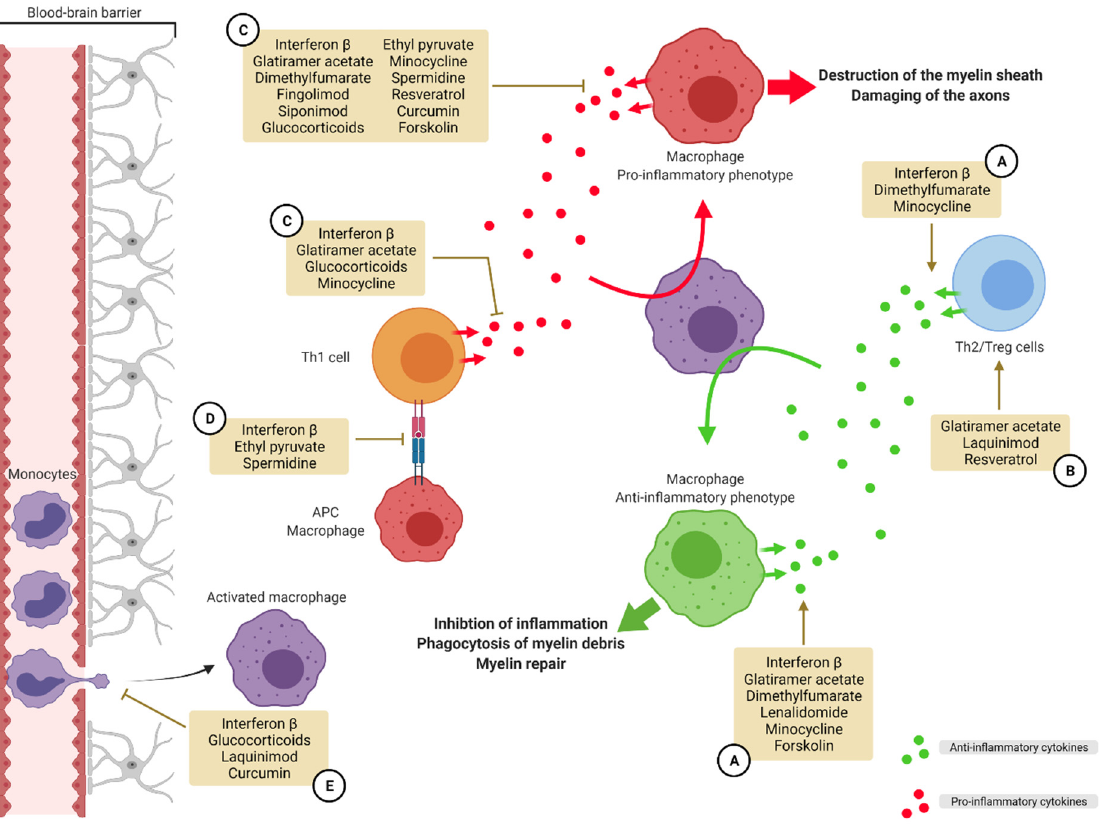
Figure 4. Targeting macrophage polarization in multiple sclerosis. In MS, macrophages adopt a M1-like phenotype promoting inflammation. A strategy for the resolution of inflammation and myelin sheath destruction is to target this polarization and push the macrophages toward a M2-like anti-inflammatory phenotype. Several compounds on the market and in development use different methods to re-educate macrophages. One strategy is to promote the secretion of anti-inflammatory cytokines by macrophages and Th2/Treg lymphocytes ( A ). Another strategy is to promote the acti- vation of Th2 and Treg lymphocytes ( B ). Another way to achieve this purpose is to inhibit the se- cretion of pro-inflammatory cytokines by macrophages and Th1 lymphocytes ( C ). Preventing anti- gen presentation by macrophages is another strategy ( D ). A last strategy is to limit extravasation of monocytes into the CNS ( E ). APC: antigen presenting cell, MS: multiple sclerosis, Th: T helper, Treg: regulatory T cells. For GBM (Figure 5), small molecules, antibodies, and nucleotides are under develop- ment with the aim to re-activate macrophages and microglia, thereby favoring anti-tu- moral immunity. For the moment, no compound has been approved on the market with a mode of action specifically targeting the polarization of macrophages/microglia.